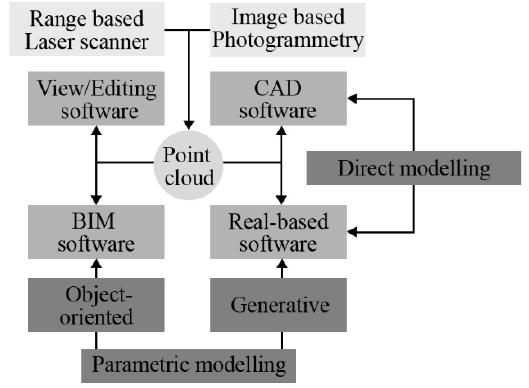
Figure 1. Point cloud management workflow: from the dense survey data to the different 3D modelling